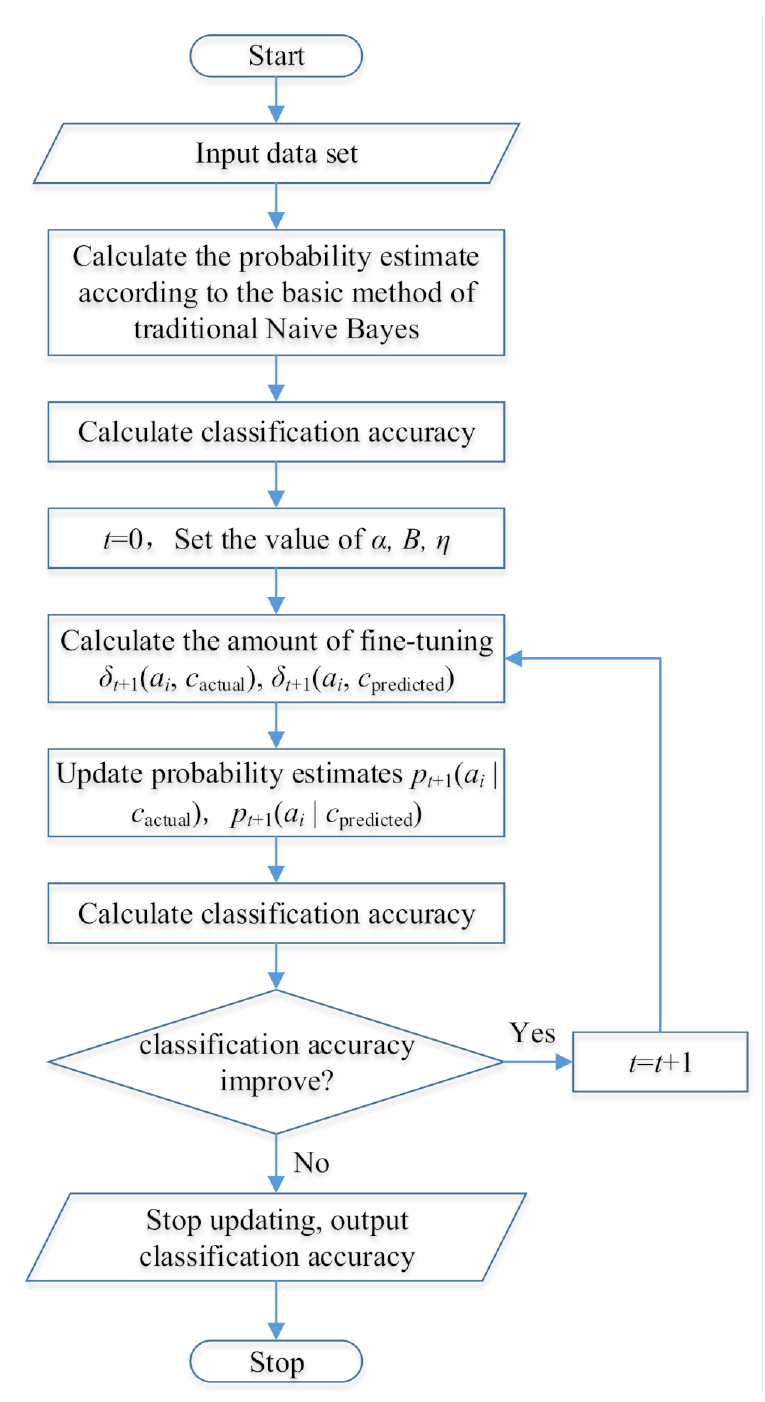
Figure 1. Flow chart of the fine-tuning Naive Bayes